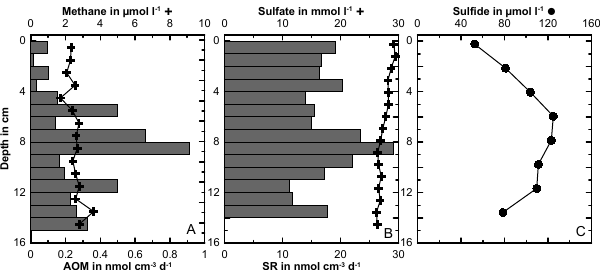
Figure 6. Solute concentrations and turnover rates in the new high- flow regime core (NHFC) after experiment termination (358d of runtime). Porewater profiles of methane ( a , crosses), sulfate ( b , crosses), sulfide ( c , circles), and results of the radiotracer measure- ments for AOM ( a , bars) and sulfate reduction ( b , bars) are shown. Figure 5. Methane concentration (µmolL − 1 ) in the outflow (a, d) , methane efflux (mmolm − 2 d − 1 ; b , e ), and calculated AOM rate (mmolm − 2 d − 1 ; c , f ) of the SLOT system before and af- ter changing the fluid flow regime: (a, b, c) low-flow regime core (LFC) and (d, e, f) high-flow regime core (HFC) from Que- pos Slide. Vertical lines mark the moment of fluid flow change (low flow → high flow and vice versa at 258d of runtime). Er- ror bars ( (a, d) ) show standard deviations of three repeated gas chromatographic measurements; the first two data points represent single measurements. Dotted lines represent the trend line (low- + 0 . 02 t + 0.285, r 2 = 0.825; flow regime: 5 × 10 − 6 × t 2 runtime runtime high-flow regime: 0.8576 × ln (t runtime ) − 0 . 8662, r 2 = 0.987) of methane concentration development until flow change. Figure 7. Solute concentrations and turnover rates in the new low flow core (NLFC) after experiment termination (358d of runtime). Porewater profiles of methane ( a , crosses), sulfate ( b , crosses), and sulfide ( c , circles) as well as results of the radiotracer measurements for AOM ( a , bars) and sulfate reduction ( b , bars) are